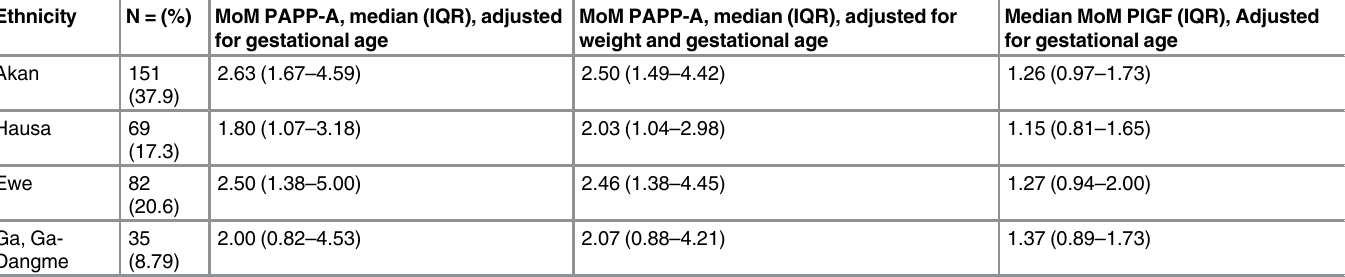
Table 3. MoM values PAPP-A and PlGF for the four main ethnic groups (n = 398 for PAPP-A, n = 365 for PlGF). Ethnicity